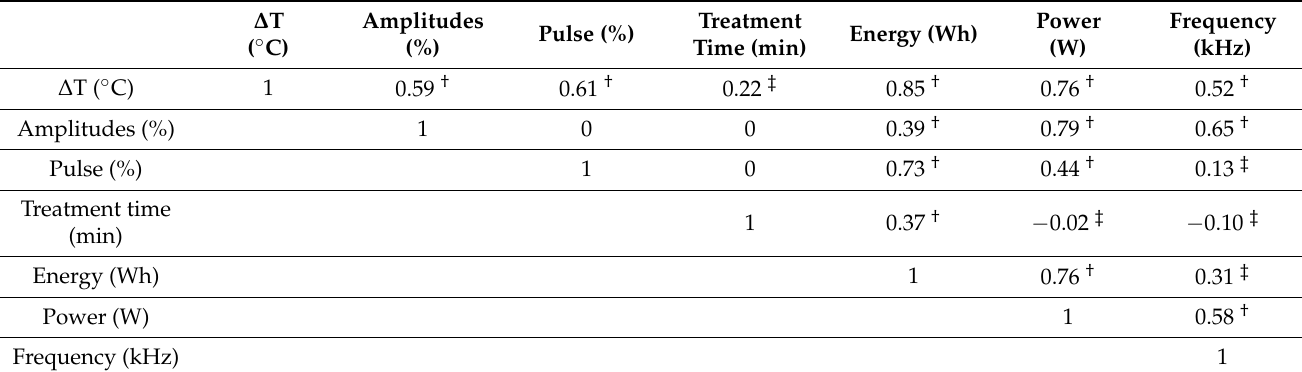
Table 6. Pearson Correlations for HPU